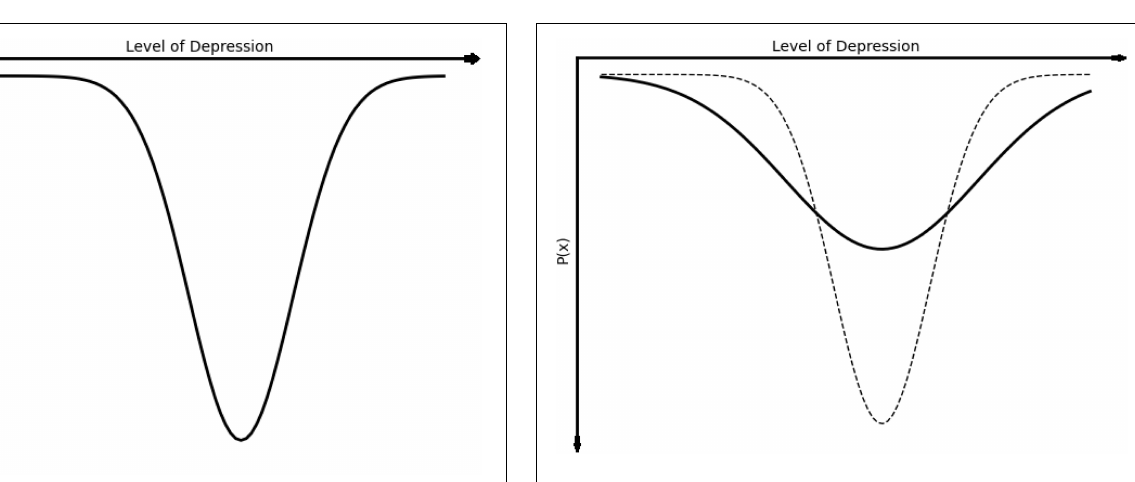
FIGURE 3 | Idealized graph showing a typical attractor state of the level of negative emotion related to depression following Tschacher and Haken (2019). The goal of therapy would be to shift the mean of this function to the left toward more positive emotions.